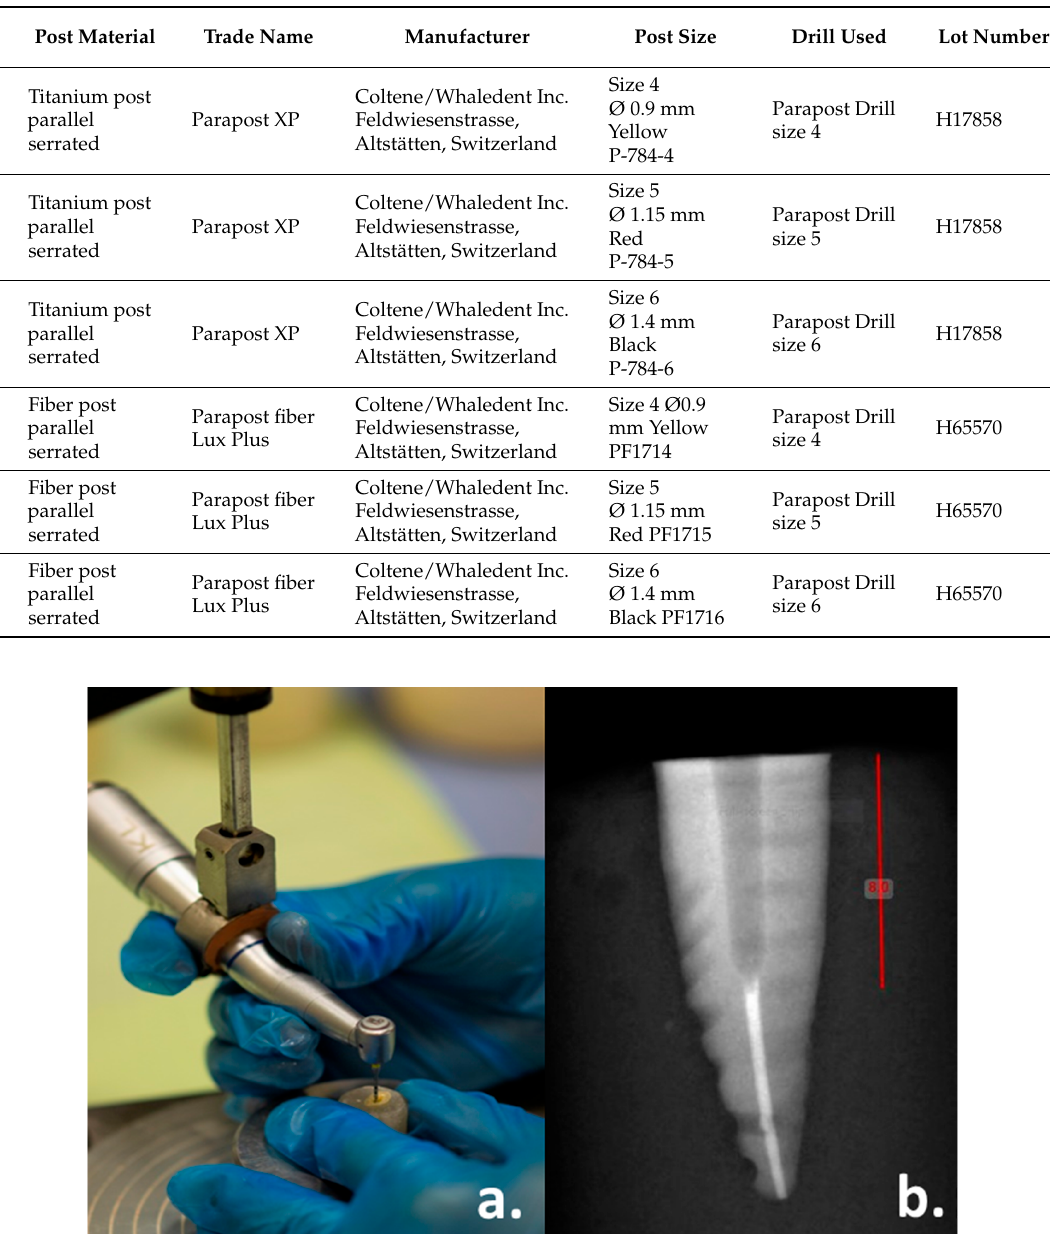
Table 1. Details of the tested post materials for each group in the present study.